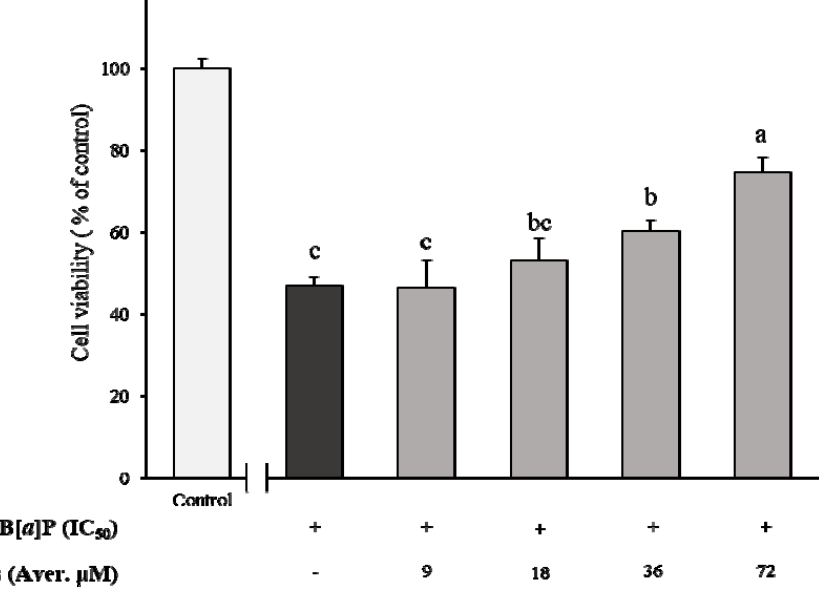
Figure 2. Determination of B[ α ]P treated HepG2 cell viability (% of control) after co-culture with different concentrations of catechins for 24 h. The values are mean ± SD in triplicate. Each bar with different letters is significantly different among treatments. a p < 0.001 as compared with control; b p < 0.001 as compared with control; c p < 0.001 as compared with control. Control indicates HepG2 cells treated by DMEM without B[ α ]P.